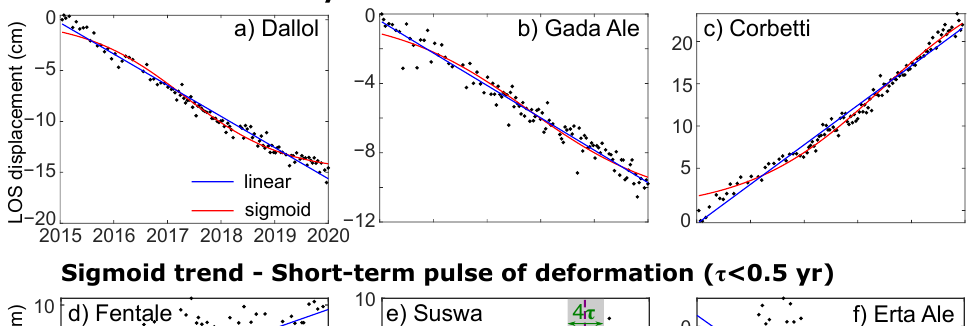
Sigmoid trend - Short-term pulse of deformation ( 𝛕 <0.5 yr)